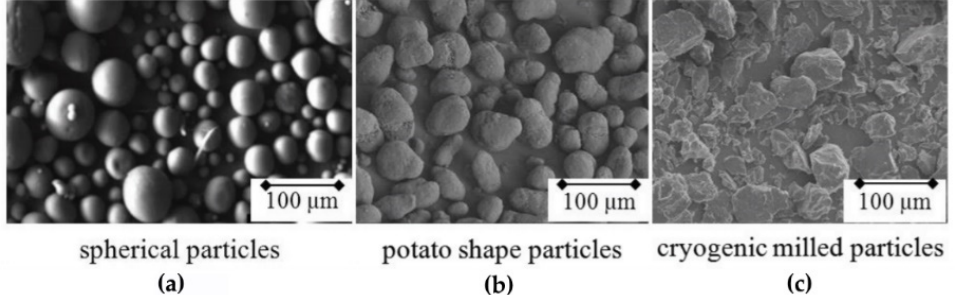
Figure 3. Particle shapes obtained by different production methods: ( a ) spherical, ( b ) potato-shaped, and ( c ) cryogenically milled particles. Reproduced with permission from [20].